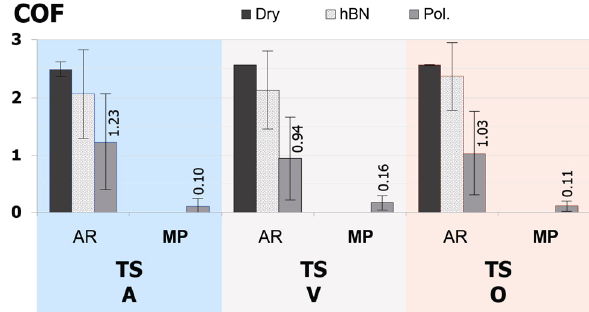
Fig. 5 Average friction levels over the last 25 s of the tribotests for all the test configurations (load 10 N, stroke length 4 mm, frequency 12.5 Hz, temp. 300 ºC).